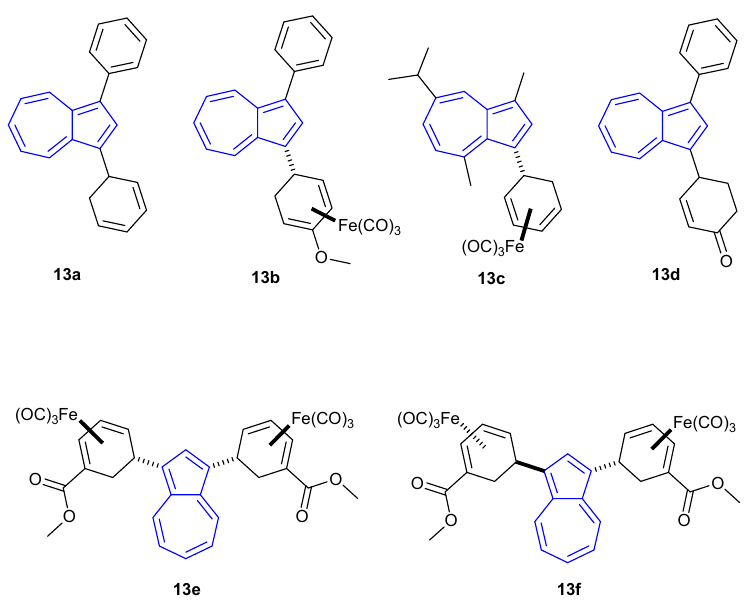
Figure 10. The 1- and 3-substituted azulenes reported by Lewis, Kann and co-workers in 2020 [29]. Aside from protonation of the azulene core, azulene monoaldehydes have likewise been shown to exhibit alterations in their fluorescence when protonated (whereby proto- nation occurs on the aldehyde moiety). Aldehydes 14 and 15 (Figure 11), reported by Li, Gao and co-workers in 2008, were shown to give considerable redshifts (> 100 nm) in their emissions when the solvent was changed from EtOH ( 14 λ em = 420 nm, 15 λ em = 428 nm) to HClO 4 ( 14 λ em = 552 nm, 15 λ em = 530 nm) or TFA ( 14 λ em = 537 nm, 15 λ em = 530 nm) [58]. The change in emission of dialdehyde 15 was similar enough to monoaldehyde 14 to suggest that only monoprotonation occurs in the former species.